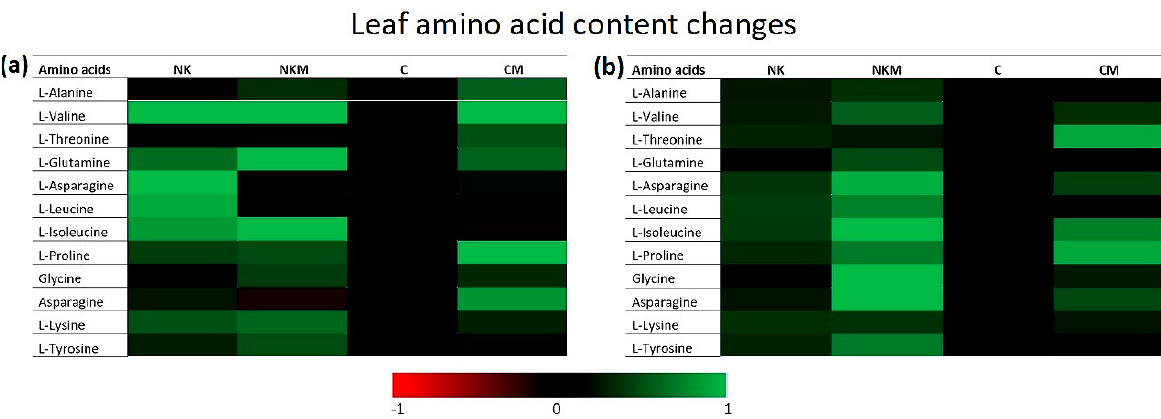
Figure 7. ( a , b ) Heatmap of leaf amino acid content changes in all treatments (NK: KNO 3 fertilizer; NKM: KNO 3 in combination with PGPR; CM: NH 4 NO 3 fertilizer in combination with PGPR) in comparison with the control (C) in the first ( a ) and second ( b ) sampling periods. The green color indicates increased levels of metabolites, while the red color indicates decreased levels of metabolites. Amounts have been expressed as relative abundance based on the relative response compared to the internal standard